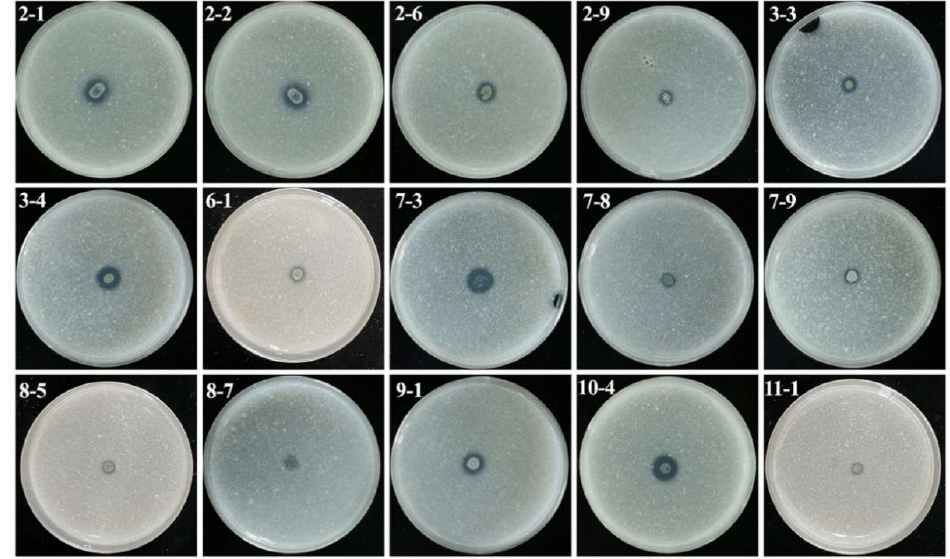
Figure 3. The phosphate solubilization ability of representative strains originating from the newly reclaimed land amendment with different organic fertilizers.